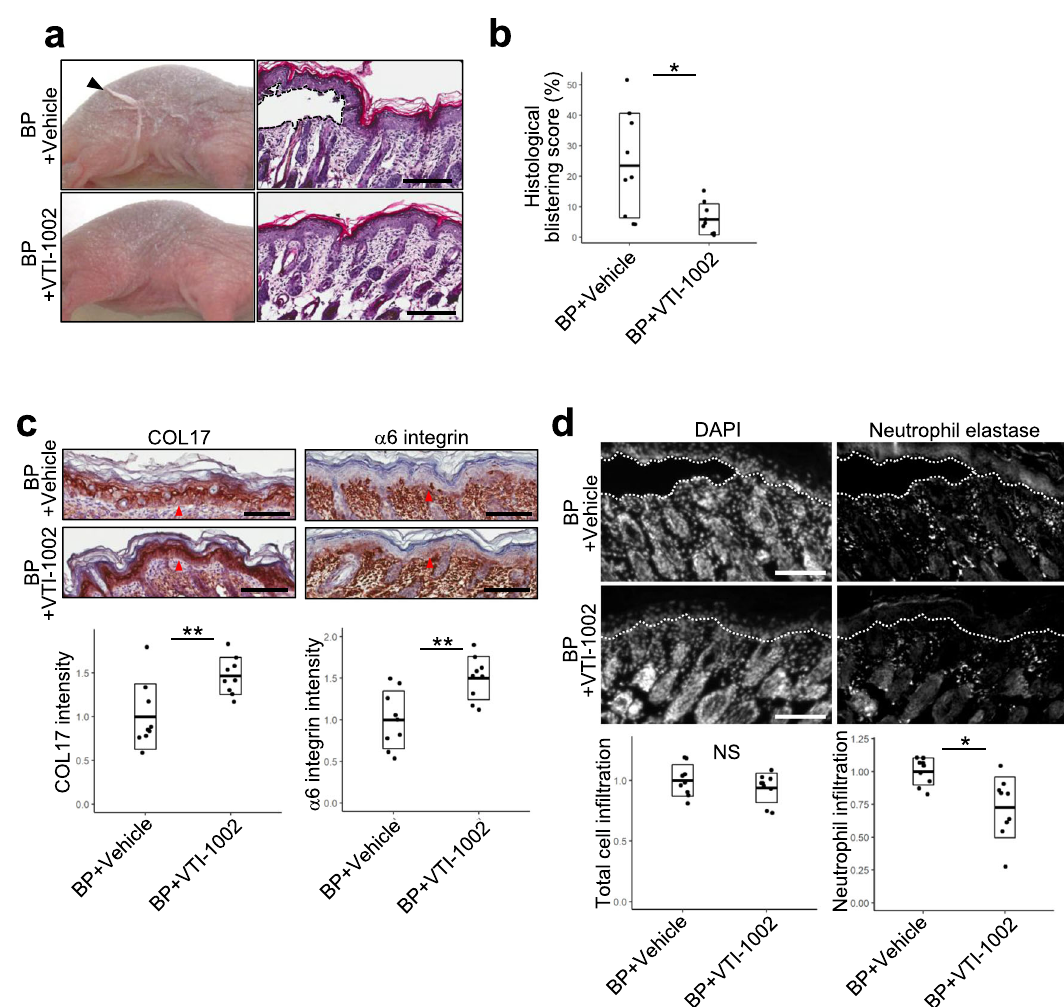
Fig. 5 Topical VTI-1002 reduces disease severity in a murine bullous pemphigoid (BP) model. a Representative clinical and H&E staining images of both vehicle and VTI-1002 gel-treated BP mouse at 48 h induced by intraperitoneal BP-IgG injection, labeled as BP + Vehicle and BP + VTI-1002 in the fi gure, respectively. An arrowhead indicates skin detachment and a dotted line demarcates major dermal – epidermal separation. Scale bar, 100 μ m. b Histological blistering scores were quanti fi ed from H&E staining images. Dot plot indicates all individual scores and box plots indicate mean ± standard deviation. N = 9 for each group. c Representative type XVII collagen (COL17) and α 6 integrin immunohistochemistry (IHC) images of both vehicle and VTI-1002 gel-treated BP mice at 48 h. Red arrowheads indicate positively stained areas at dermal – epidermal junction. Scale bar, 100 μ m. Dot plot indicates all individual scores and box plots indicate mean ± standard deviation of the intensity levels of COL17 and α 6 integrin, which were quanti fi ed from IHC images and presented as relative to the mean score of vehicle gel-treated BP mice. N = 9 for each group. d Representative IHC images of both vehicle and VTI-1002 gel-treated BP mice at 48 h stained with neutrophil elastase antibody and 4 ʹ ,6-diamidino-2-phenylindole (DAPI). White dotted lines indicate the dermal – epidermal junction. Scale bar, 100 μ m. Left and right dot plots indicate all individual scores and box plots indicate mean ± standard deviation of relative total cell in fi ltration score and relative neutrophil in fi ltrating score, respectively. Both scores are presented as relative to the mean scores of vehicle gel-treated BP mice. N = 9 for each group. In the all plots, NS = not signi fi cant, * P < 0.05, ** P < 0.01 (two-sided Student ’ s t -test).